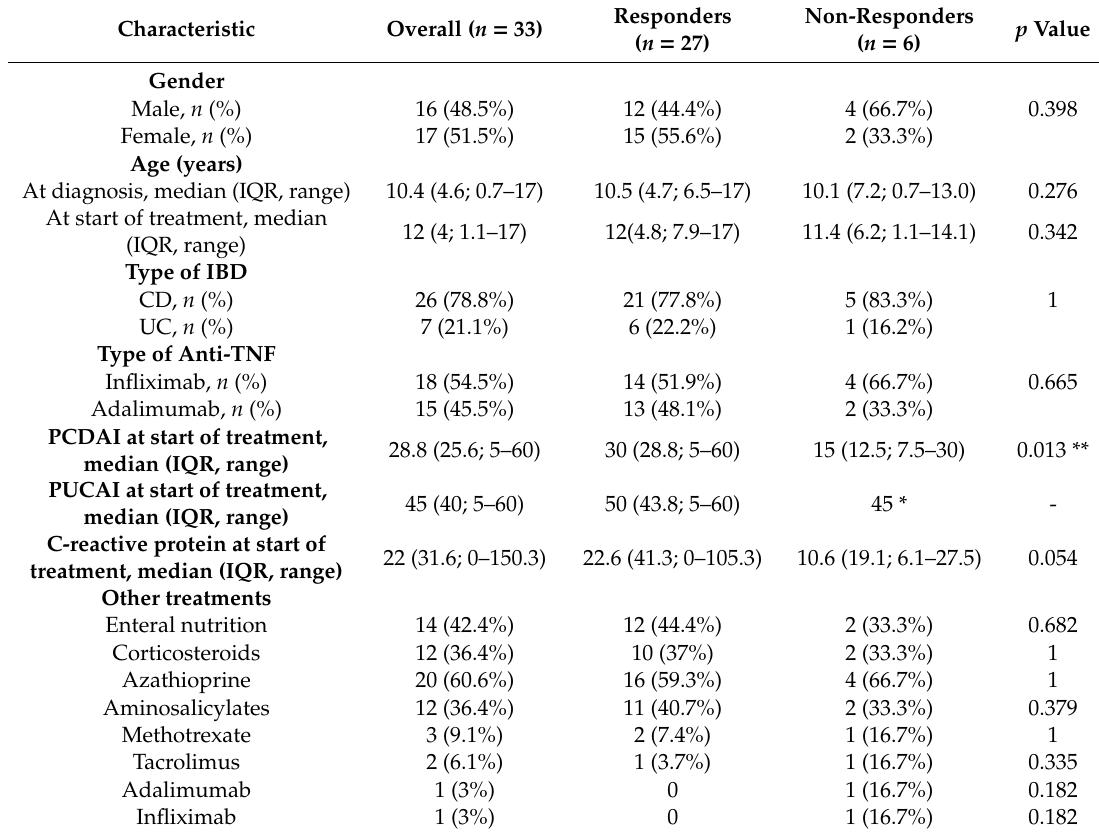
Table 1. Characteristics of